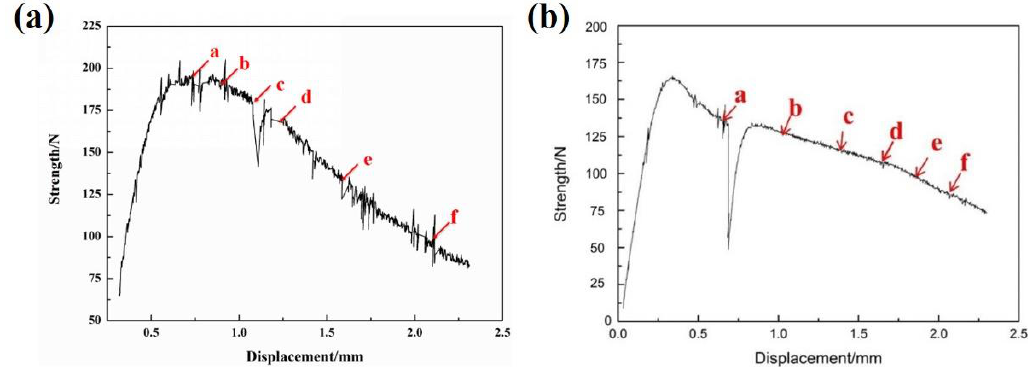
Figure 3. In-situ tensile stress-displacement curve of the investigated alloys during 650 °C tensile process: ( a ) HBA, ( b ) LBA.